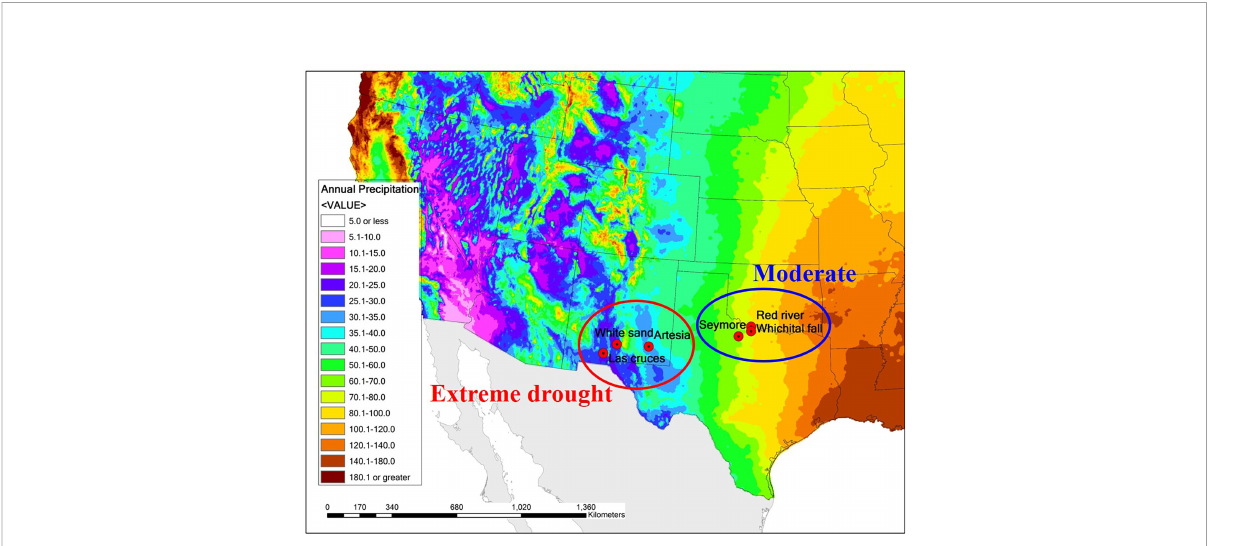
FIGURE 1 A map of the sampling sites for saltcedar genotypes used in the common garden study. Color gradients on the map represents the average annual precipitation (cm) for the past 30 years based on USDANRCS climate data. Populations sampled in the region with moderate environment with average annual precipitation of ~1000mm are circumscribed in blue, whereas populations sampled in the region with drought environment with average annual precipitation ~200mm in red